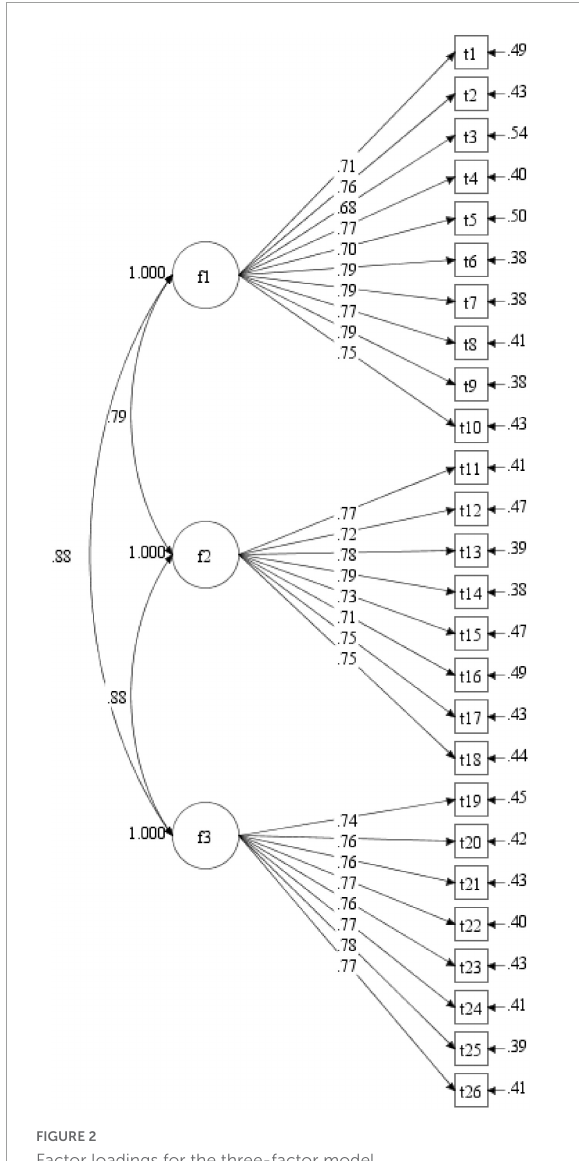
FIGURE2 Factor loadings for the three-factor